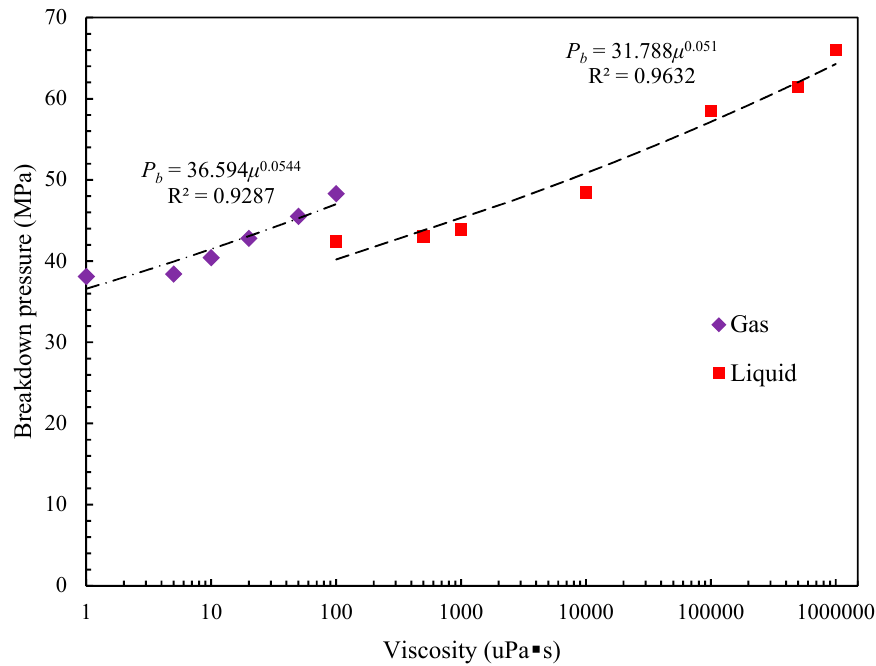
Figure 14. Relationship between breakdown pressure and fracturing fluid viscosity.